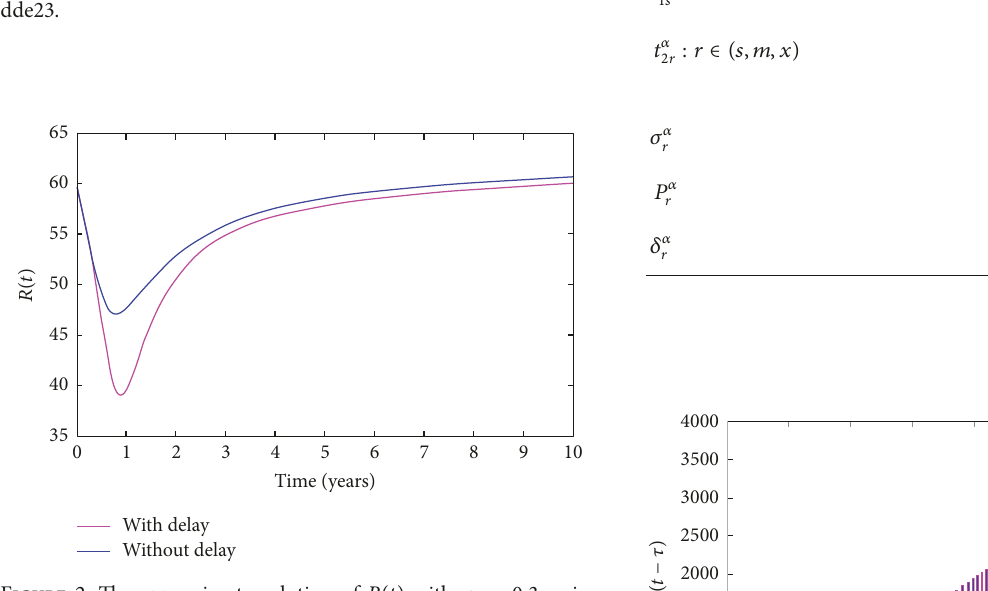
Figure 2: The approximate solution of 𝑅(𝑡) with 𝜏 = 0.3 , using NSFDM, 𝛼 = 1 .